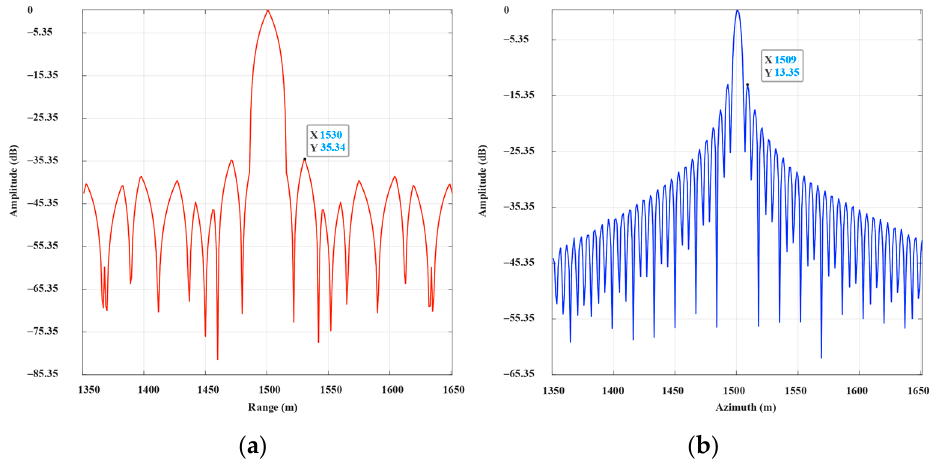
Figure 7. Evaluated results for point target 25, ( a ) is range profile and ( b ) is azimuth profile. Table 3. Comparison of imaging quality on the CPU and GPU.